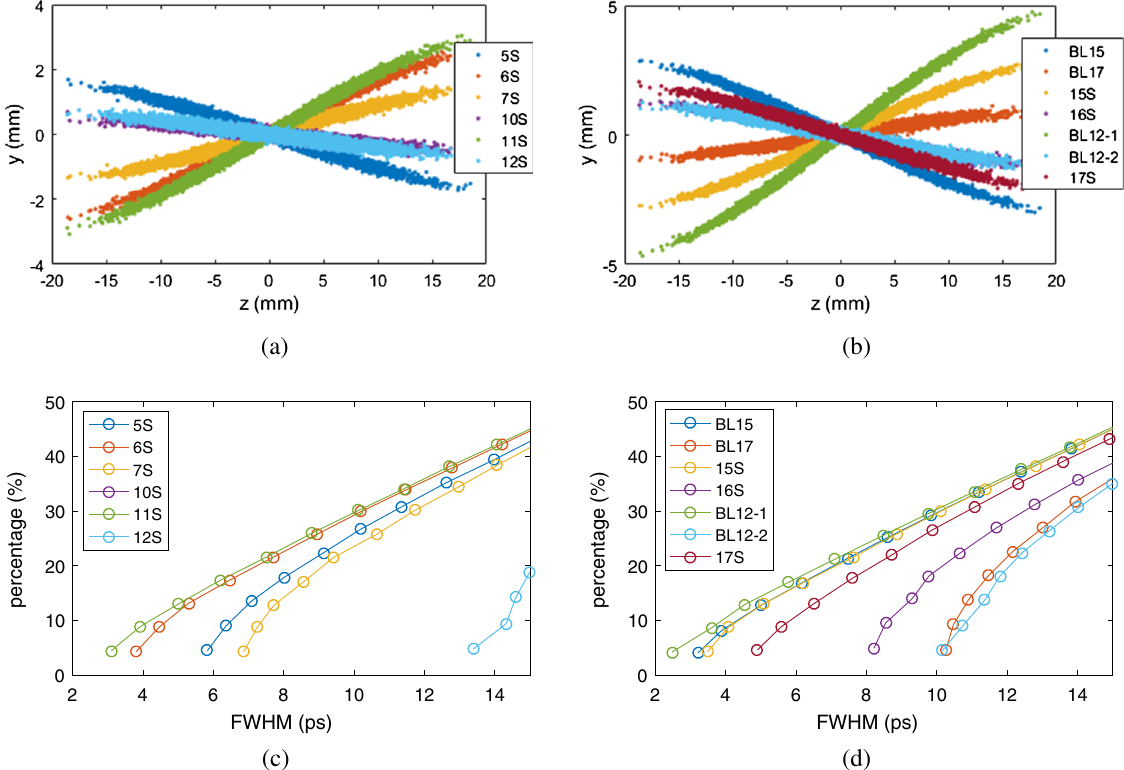
FIG. 3. (a – b) Photon beam distribution at the slit for the SPEAR3 case with simple drift between the source points and the slits. (c – d) The flux percentage vs short pulse duration, not considering bunch lengthening. The crab cavities are located in the 1S straight section and deflecting voltage for the first frequency is V 1 ¼ 1 MV. Beside the existing undulator beamlines, other straight sections that could be upgraded are also shown (as indicated by 5S, 6S, etc.), using BL15 photon